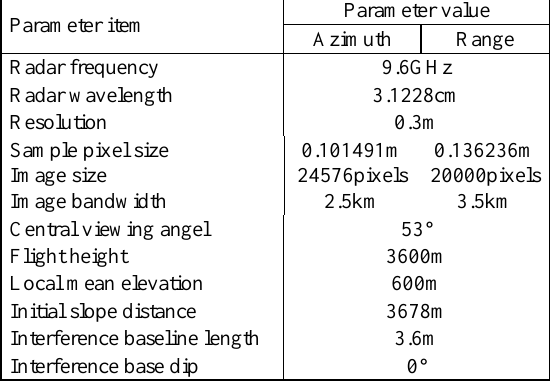
Table 1 . Data parameter